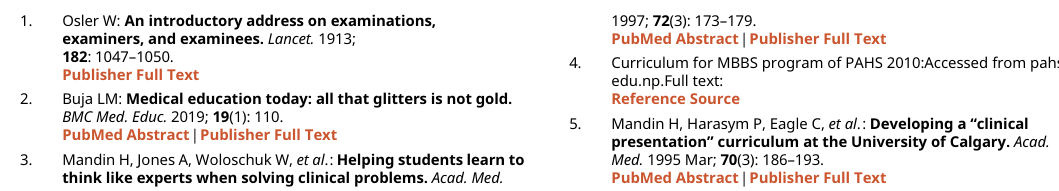
Figshare: CP Curriculum Raw data updated in Excel and PDF. https://doi.org/10.6084/m9.figshare.18666410.v1